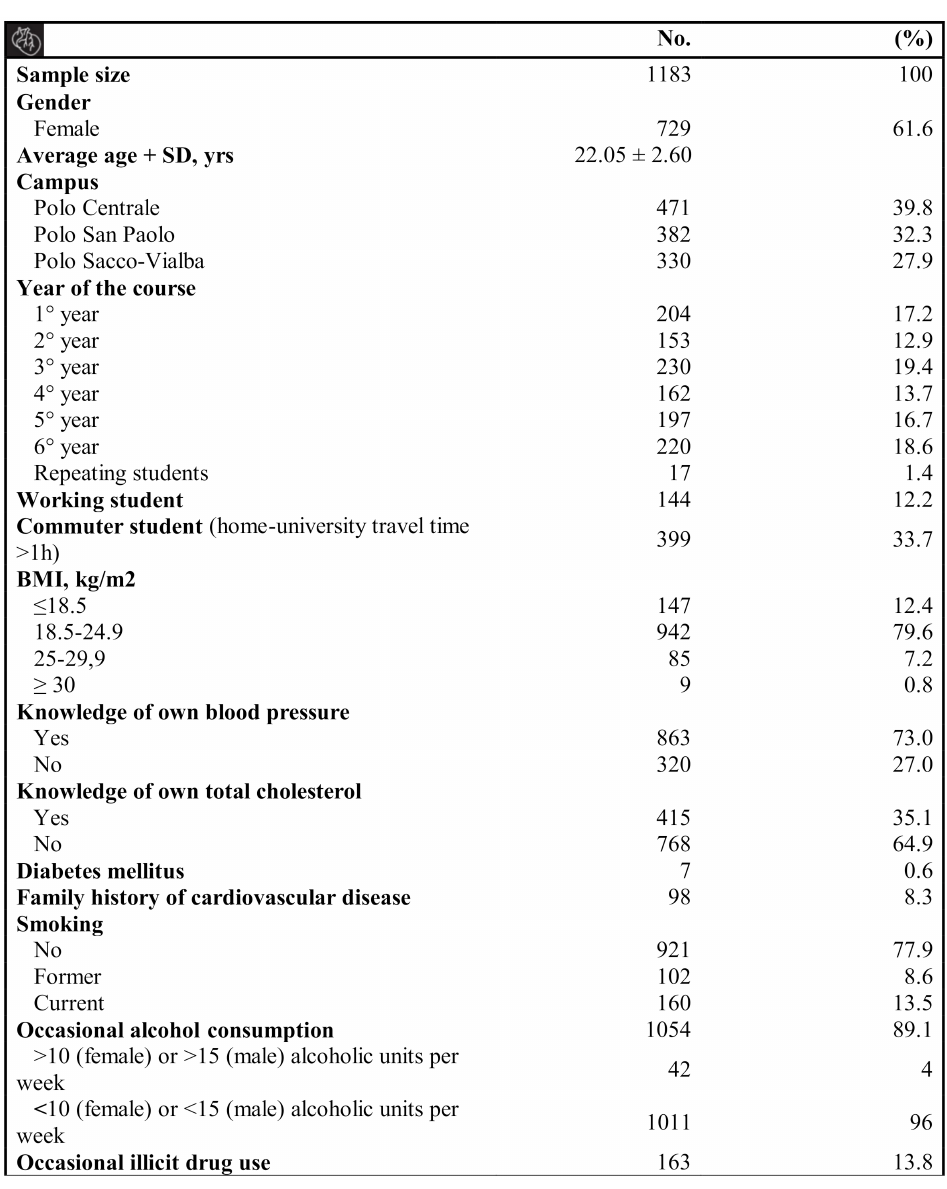
Figure 3. Students’ general and clinical